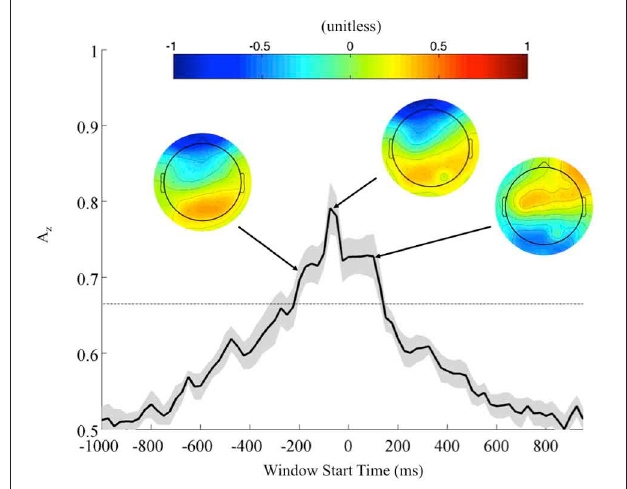
FIGURE 4 | Mean (black) and standard error (gray shading) stimulus-locked leave-one-out discrimination performance across all discriminating subjects ( p < 0 . 01, Bonferroni corrected). Included subjects had at least one false discovery rate (FDR) corrected window on a subject-level analysis. This leaves eight subjects from the original eleven, yet due to this criterion the discriminating window across subjects now more closely resembles the timing for the P300. Normalized forward models across discriminating subjects show the progression of significant discriminating activity, with higher values indicating discrimination for the targets (TC) and lower values for the standards (SC).